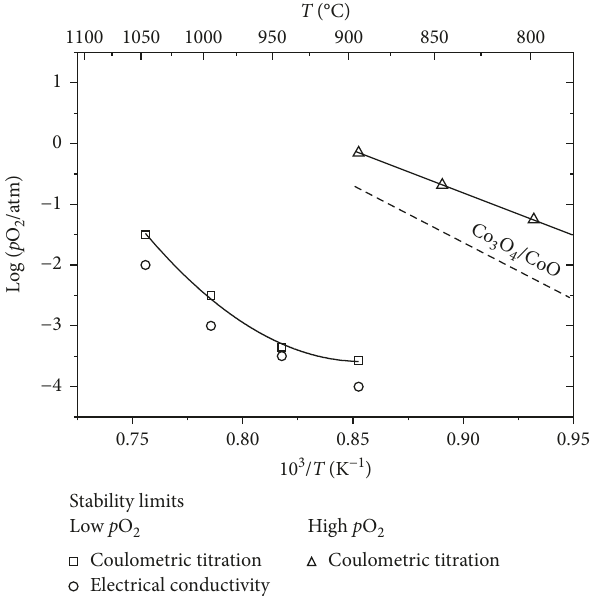
Figure 6: Thermodynamic stability limits of YBaCo